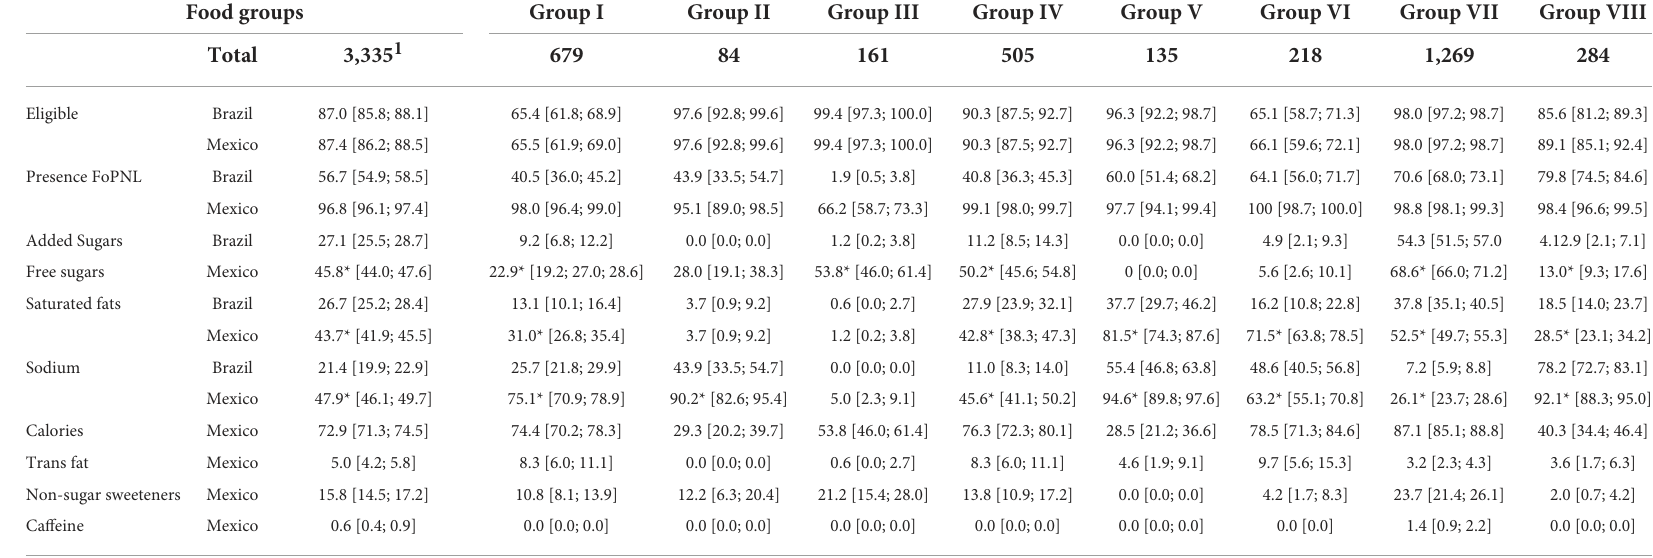
TABLE 2 Total number of collected food and drinks products, eligible for front-of-pack nutrition labeling (FoPNL), and receiving it according to Mexican and Brazilian Nutrient Profile